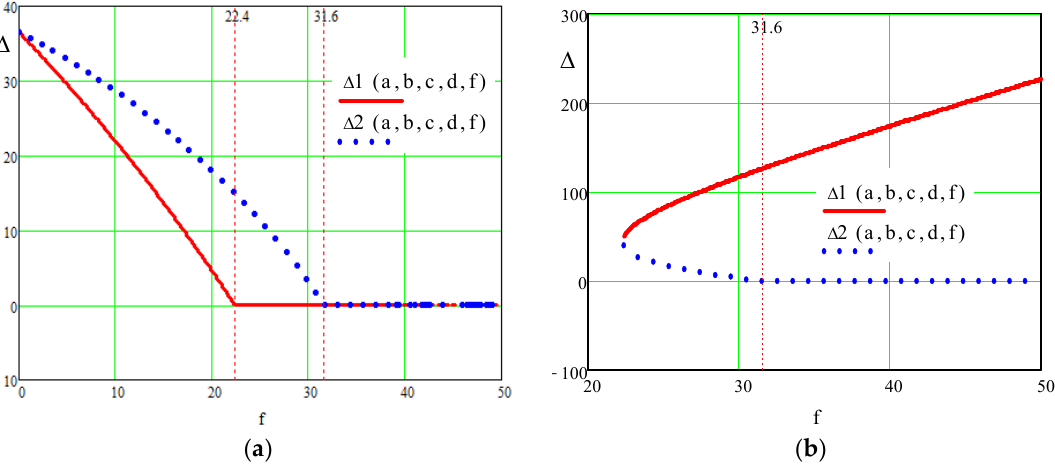
Figure 3. Determining the range of permissible values of the parameter f for Equation (1): ( a ) c = − 4; ( b ) c = 4.